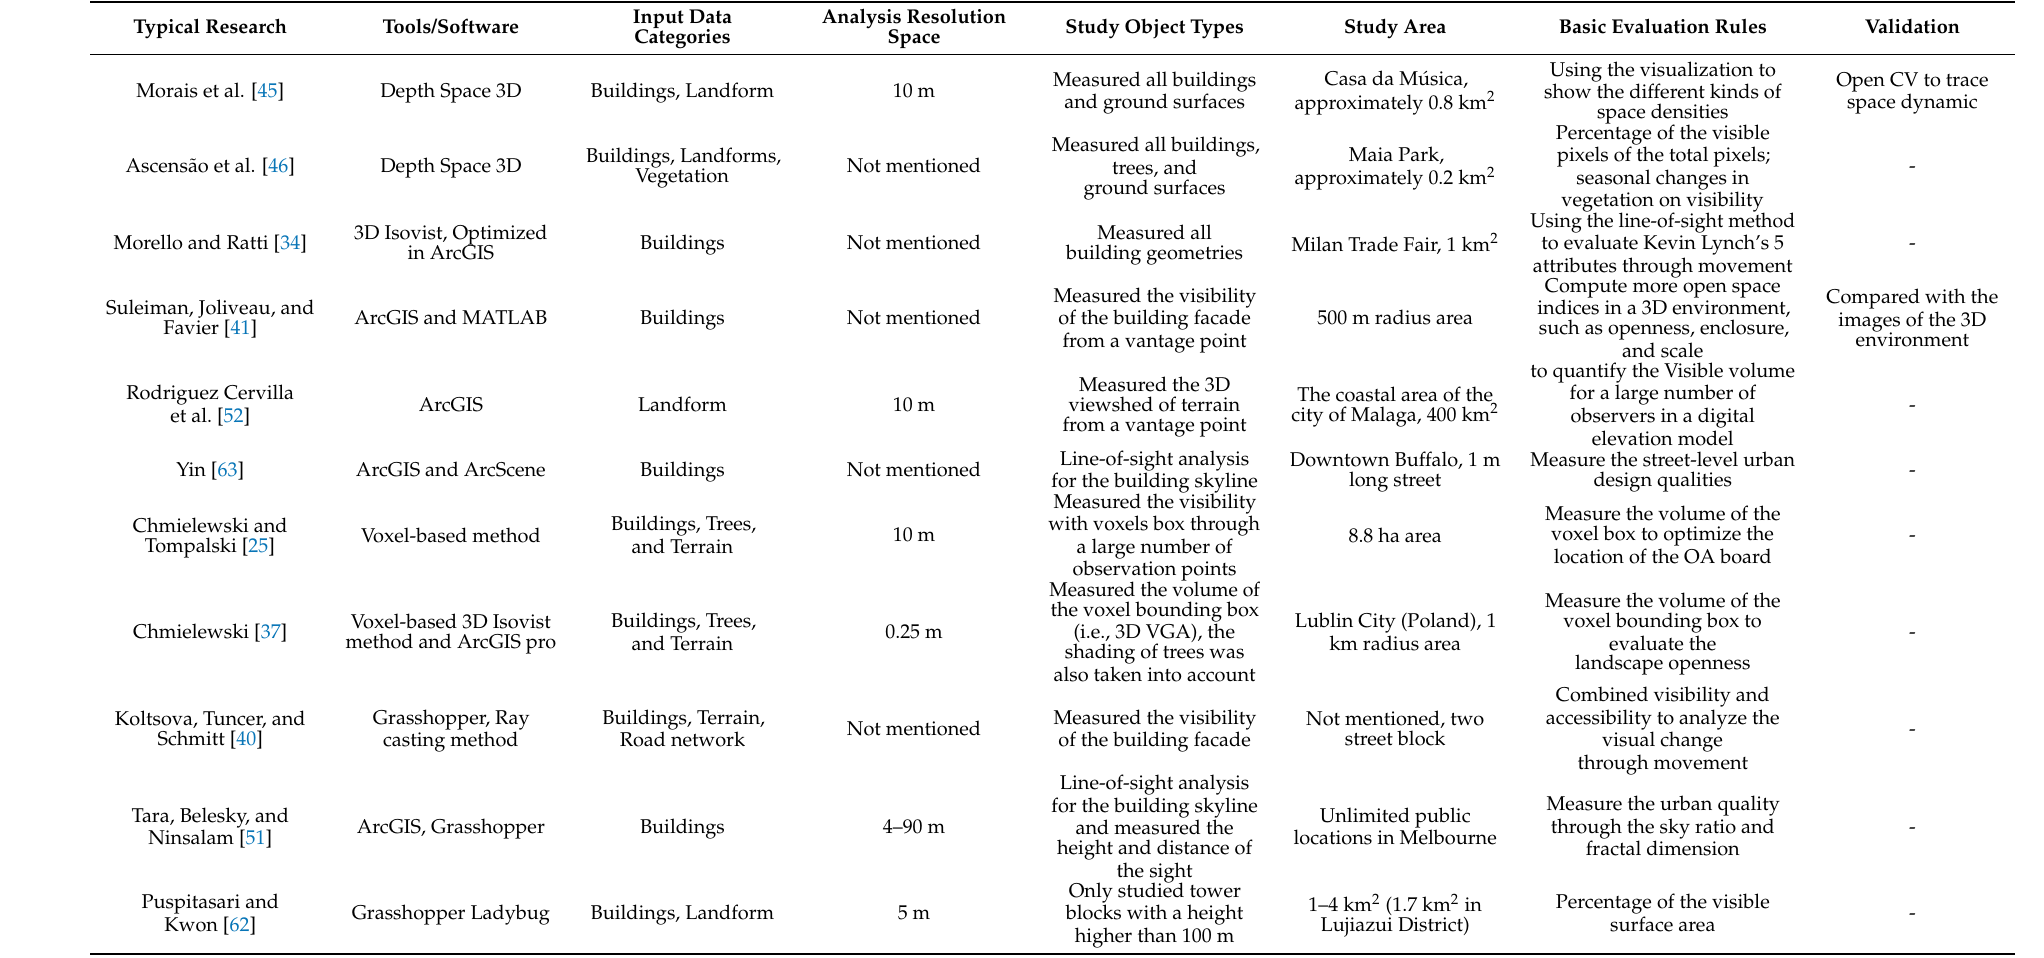
Table 4. Typical research and case